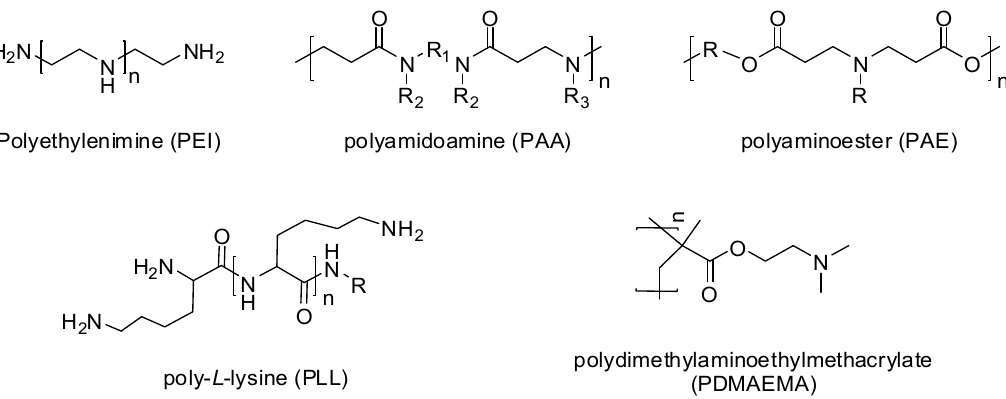
Figure 2. Chemical structures of cationic polymers.